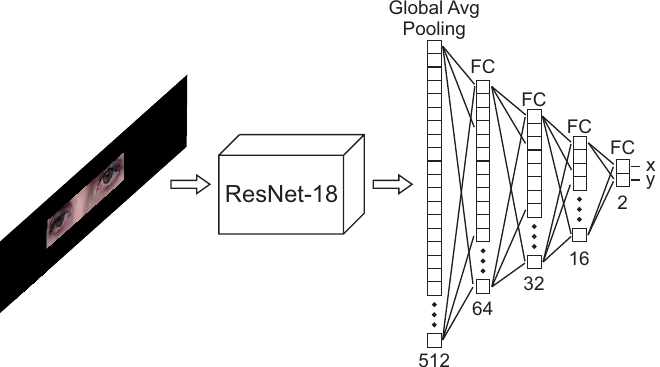
Figure 5. Architecture proposed. The backbone consists of a Resnet-18 to extract meaningful characteristics from the image. Then, these characteristics are fed into a fully connected regressor network to obtain the final gaze components. Image used as input to the network from the I2Head database